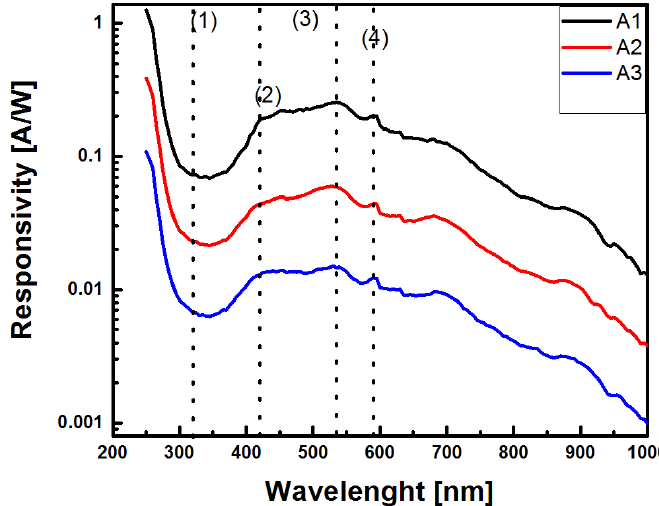
Figure 18. Responsivity of Au/SRO/Si structures at − 4V.